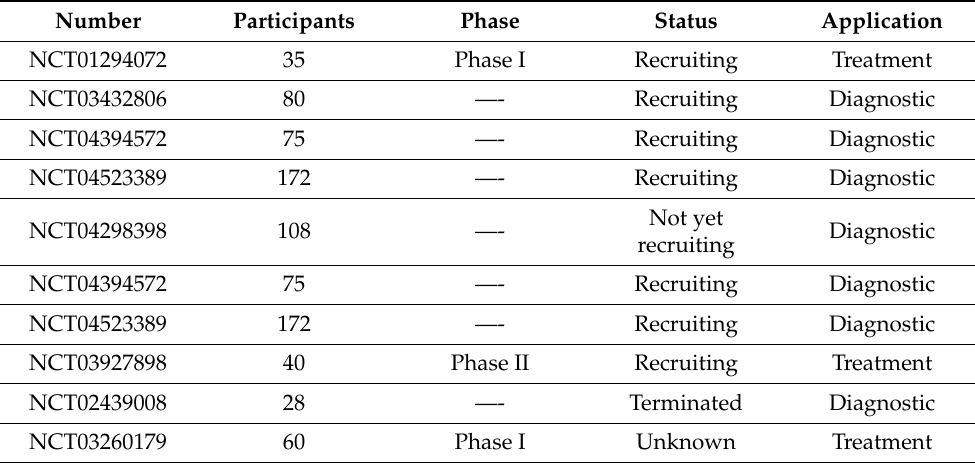
Table 4. Current clinical trials involve EVs for colorectal